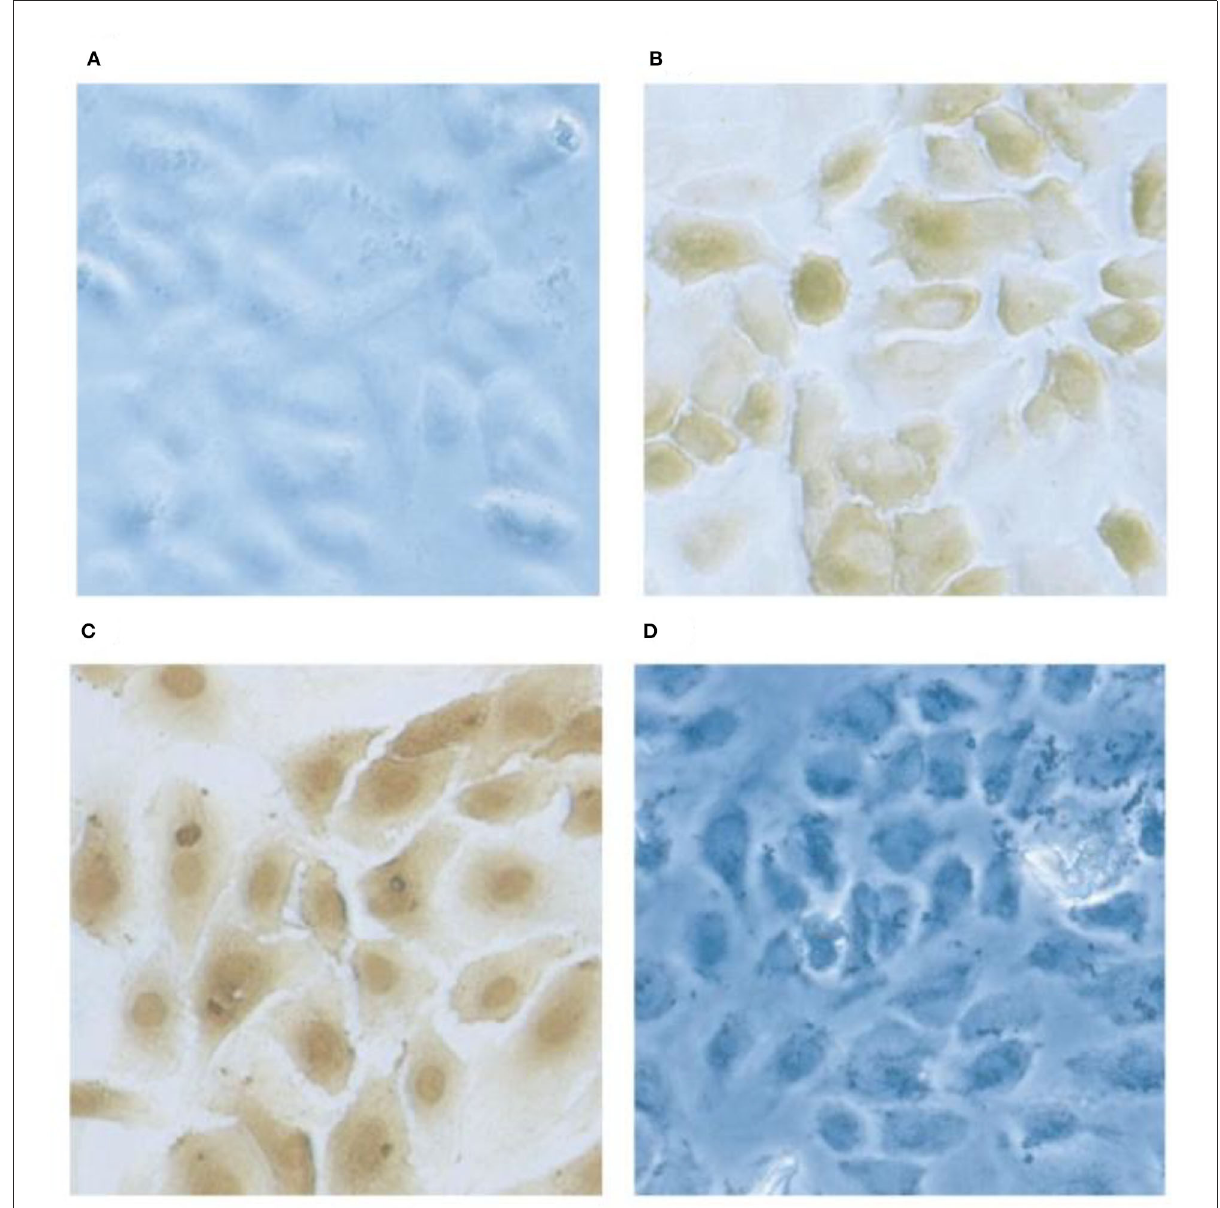
FIGURE6 Localization of gC1qR on HUVEC’s by immunochemical staining. Monolayer cultures of HUVECs on slides are fixed using 4% formaldehyde. The cells were first probed with rabbit anti gC1qR antibody and subsequently with horse radish -labeled goat anti-rabbit IgG. The gC1qR was visualized by 3,3-diaminobenzidine. Preimmune rabbit IgG staining showed no signal (A) and the anti-gC1qR antibody stained at the cell surface in non-permobilized cells (B) while in permimobilized cells (C) , the perinuclear and nuclear regions were prominently stained. In D , the cells were treated as in (B) but the antibody was pretreated with excess recombinant